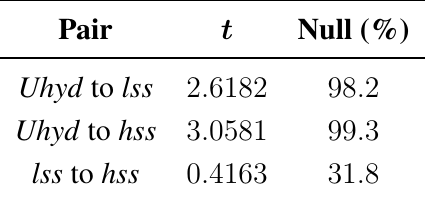
Table 5. The calculated T -test results ( t ) for compliance measurements and the determined probability for rejection of null hypothesis (Null). High percentile value indicates greater statistical significance between the tested specimen